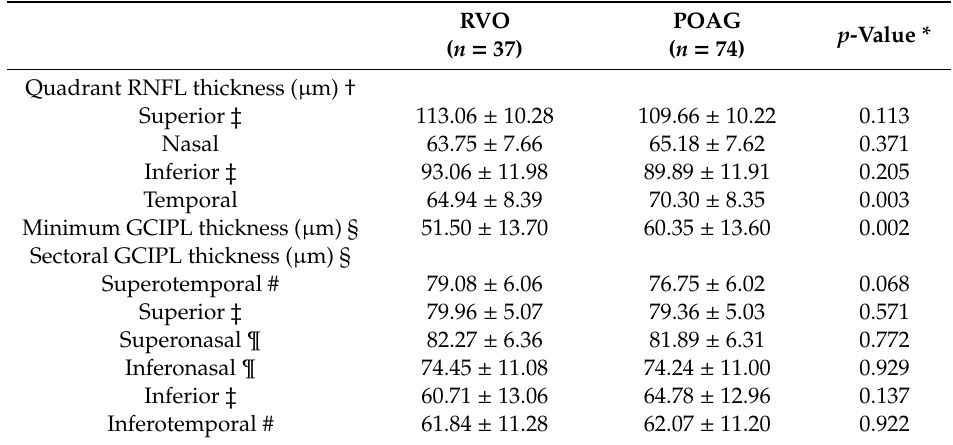
Table 2. Comparison of peripapillary RNFL and macular GCIPL thickness in patients with retinal vein occlusion and primary open-angle glaucoma.